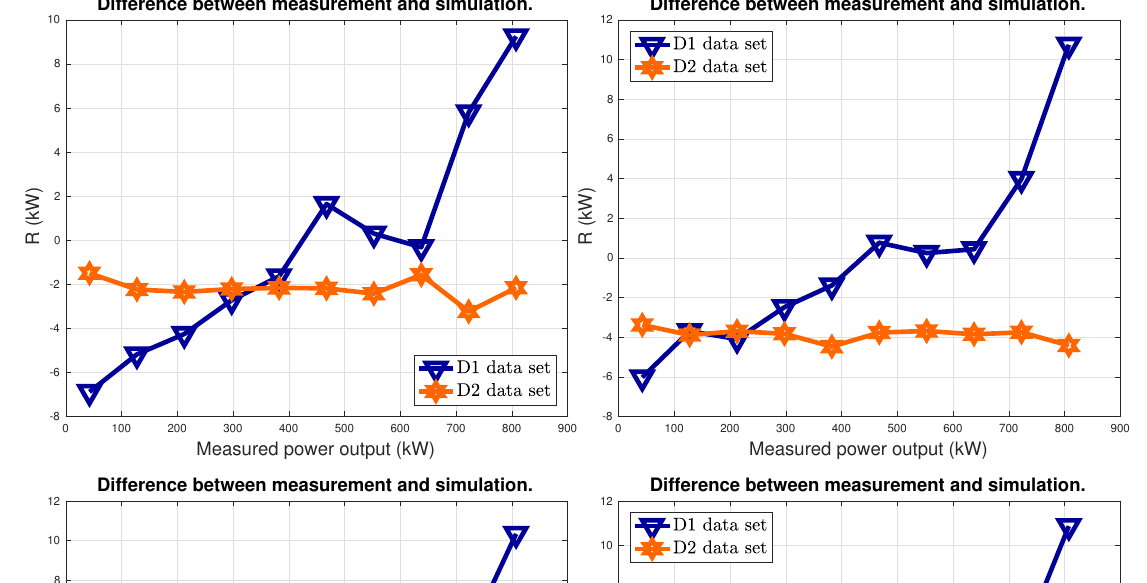
Difference between measurement and simulation.